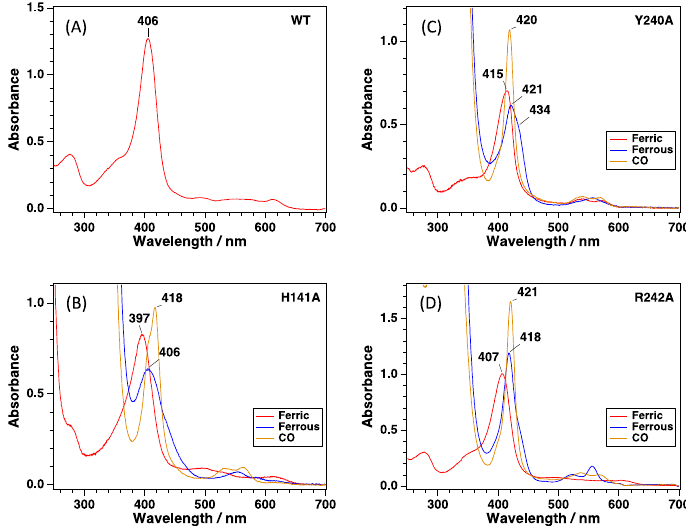
Figure 3. Electronic absorption spectra of ( A ) wild-type (WT), ( B ) H141A-, ( C ) Y240A-, and ( D ) R242A-CgHmuT. The only ferric spectrum is shown for wild-type CgHmuT because it is not reduced by dithionite.